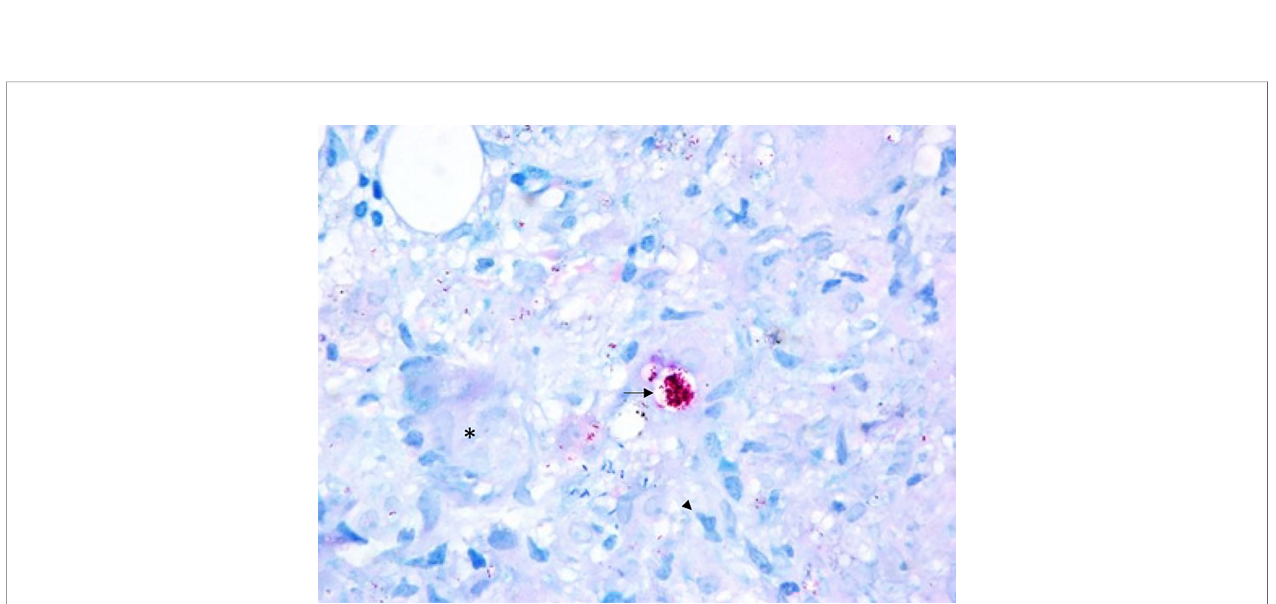
FIGURE 2 | Bone Marrow - Epithelioid granuloma composed of macrophages (arrow head) and multinucleated giant cells (*) rich in bacilli, which may present in isolation or bound together forming globi (arrow), what distinguishes M. leprae from other mycobacteria (100x,